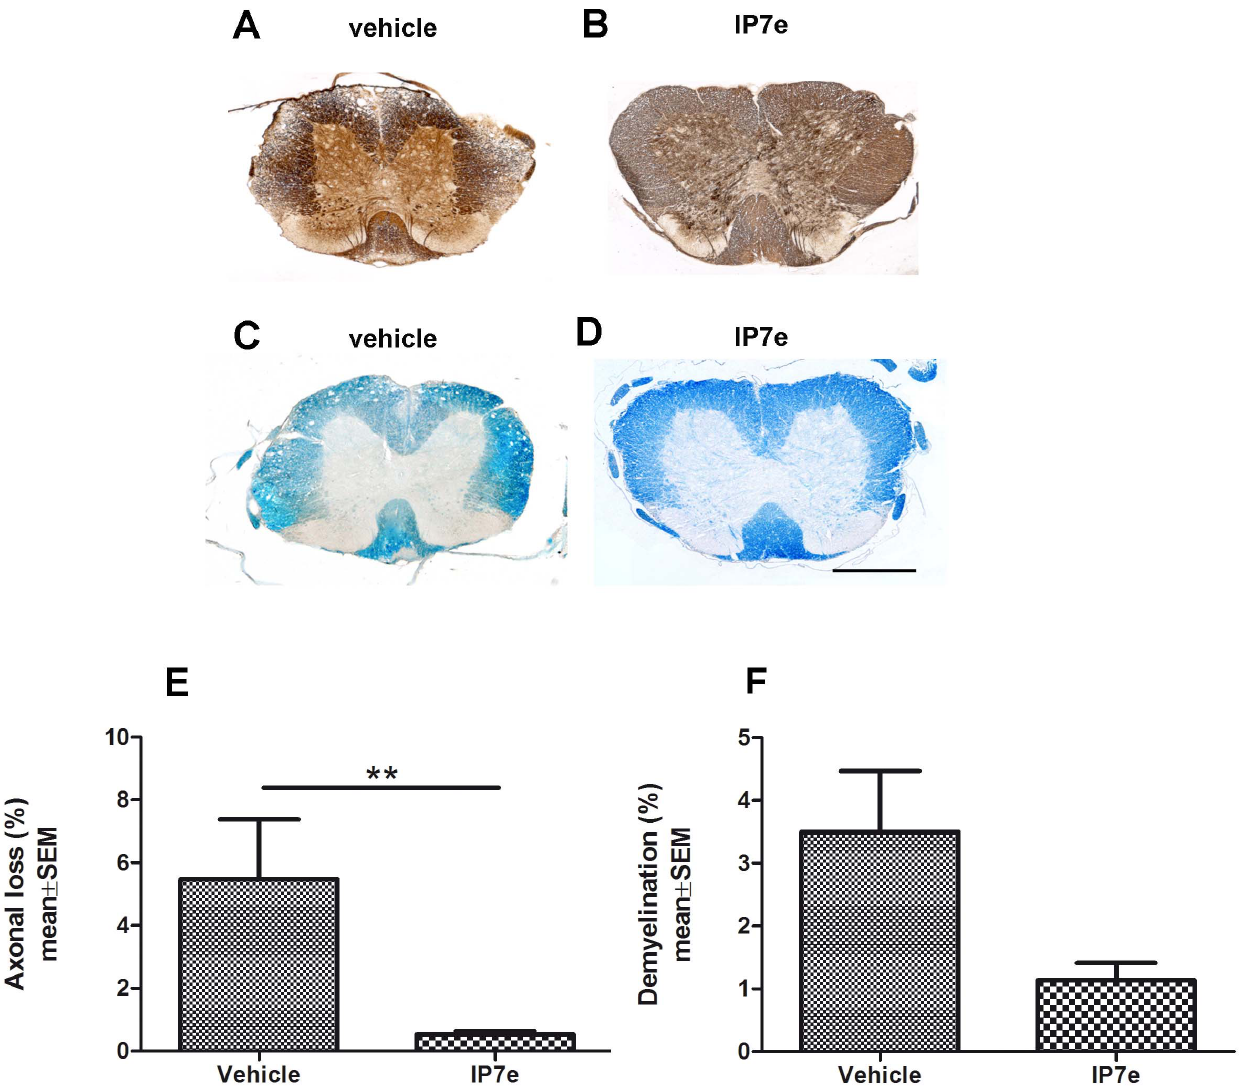
Figure 2. Preventive administration of IP7e reduces axonal damaged area in the spinal cord of mice with EAE. Coronal sections of spinal cord of IP7e (B, D) and vehicle (A, C) –treated EAE mice. Axonal damage and demyelination are measured using respectively the Bielshowsky (A, B) and the Luxol fast Blue (C, D) staining in the spinal cord of IP7e (n=5) and vehicle (n=5) -treated EAE mice. Calibration bar, 250 m m. Quantification shows that the extent of neuronal damage (E) after IP7e treatment is significantly decreased, while the extent of demyelination (F) shows a tendency to decrease after IP7e treatment compared to vehicle- treated mice. (Student’s t test, **: P , 0.01). Data are expressed as mean 6 SEM. (IP7e; isoxazolo- pyridinone 7e, SEM; standard error of mean).